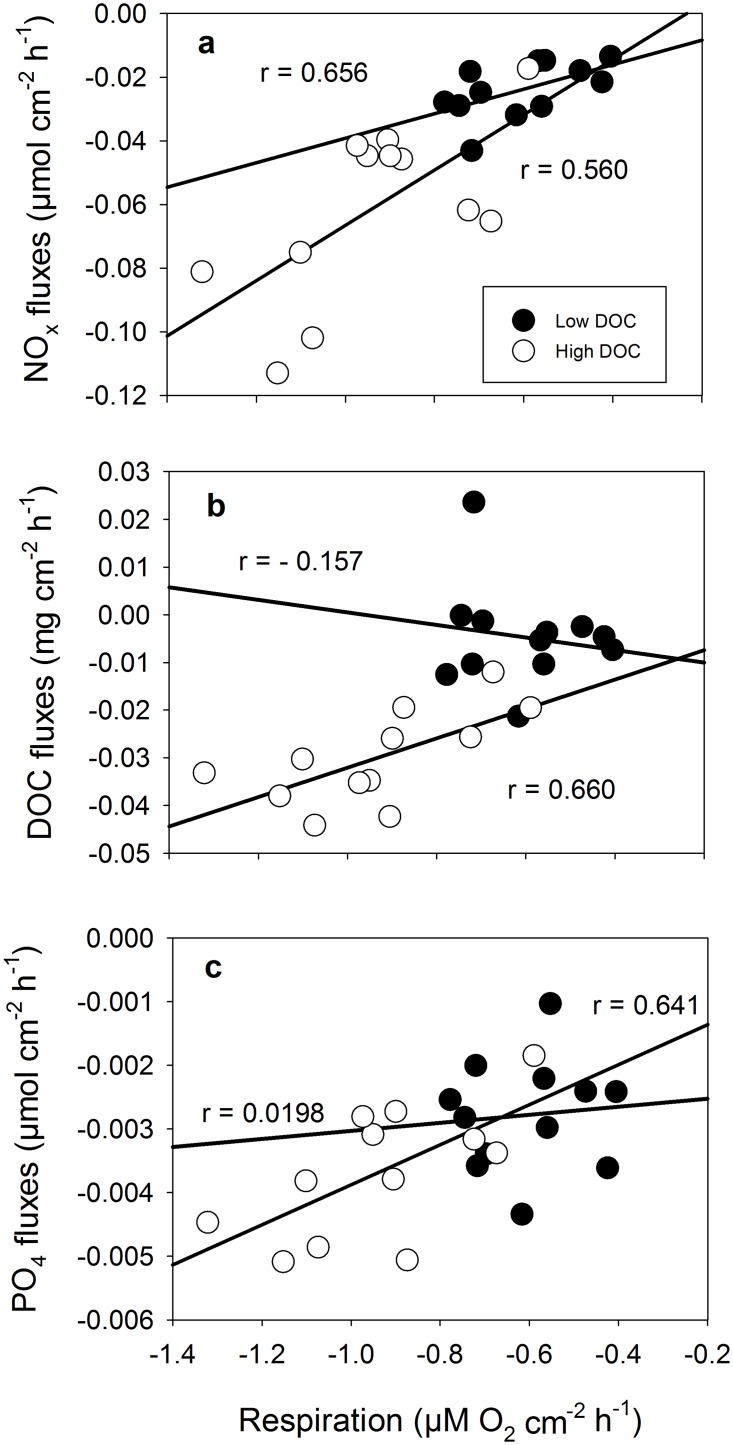
Correlation of response variables in for different DOC concentrations of Halimeda opuntia.(a) NOx fluxes, (b) DOC fluxes and (c) PO4 fluxes versus respiration at low (filled circles) and high (empty circles) DOC concentration. Pearson’s correlation coefficient (r) is given for each relationship for low and high DOC concentration.